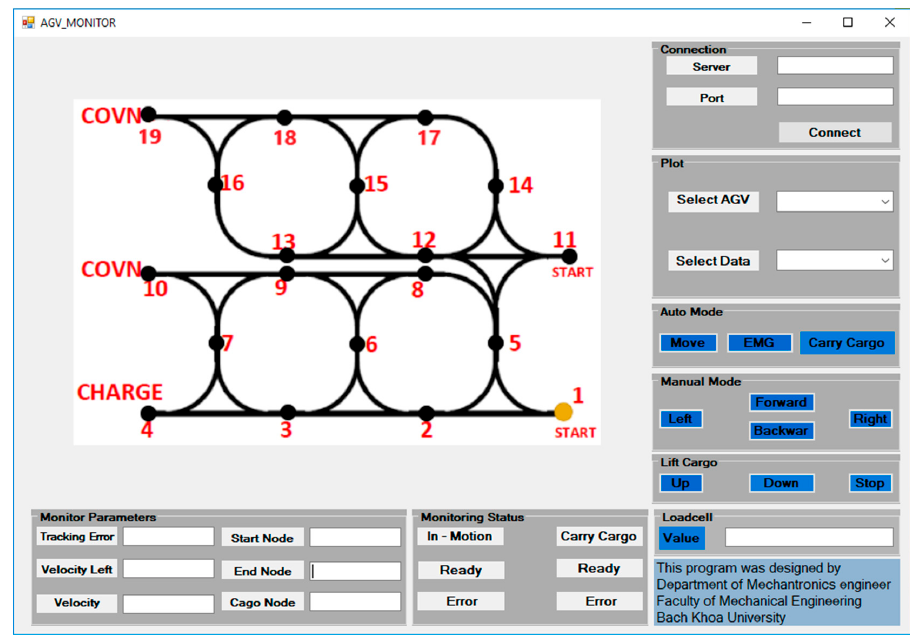
Figure 8. Graphical user interface of an open software platform. Table 2. List of API function groups.